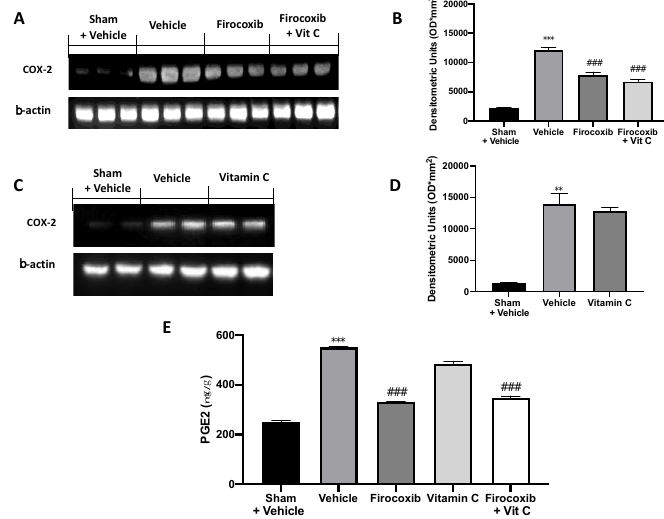
Figure 2. Effect of combined firocoxib and vitamin C therapy on cyclooxygenase (COX)-2 and PGE2 expression: Western blot analysis of ( A ) COX-2, ( B ) densitometric analysis, ( C ) COX-2, ( D ) densitometric analysis, ( E ) PGE2 expression. n = 5 animals from each group for each analysis. A p -value of < 0.05 was considered significant; ** p < 0.01 vs. sham + vehicle, *** p < 0.001 vs. sham + vehicle, and ### p < 0.001 vs. vehicle.